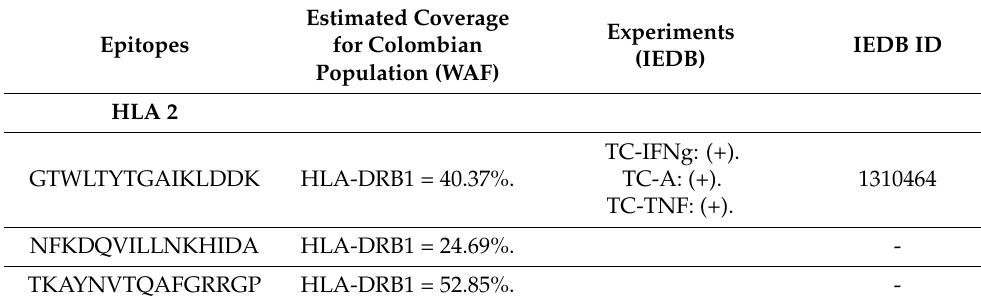
Estimated Coverage